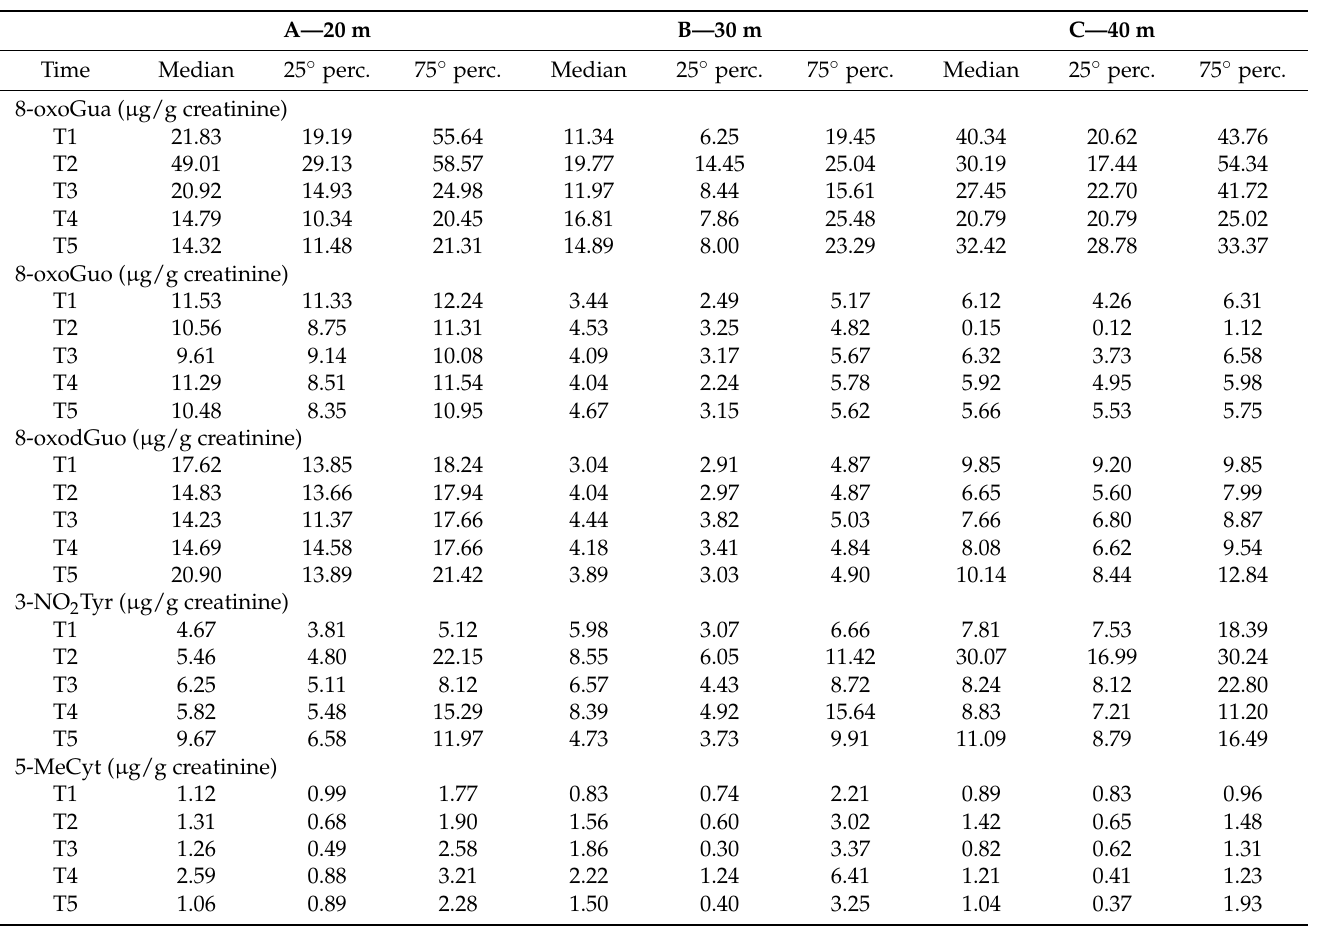
Table 2. The median concentrations of 8-oxoGua, 8-oxoGuo, 8-oxodGuo, 3-NO 2 Tyr, and 5-MeCyt in the five divers. A—20 m B—30 m C—40